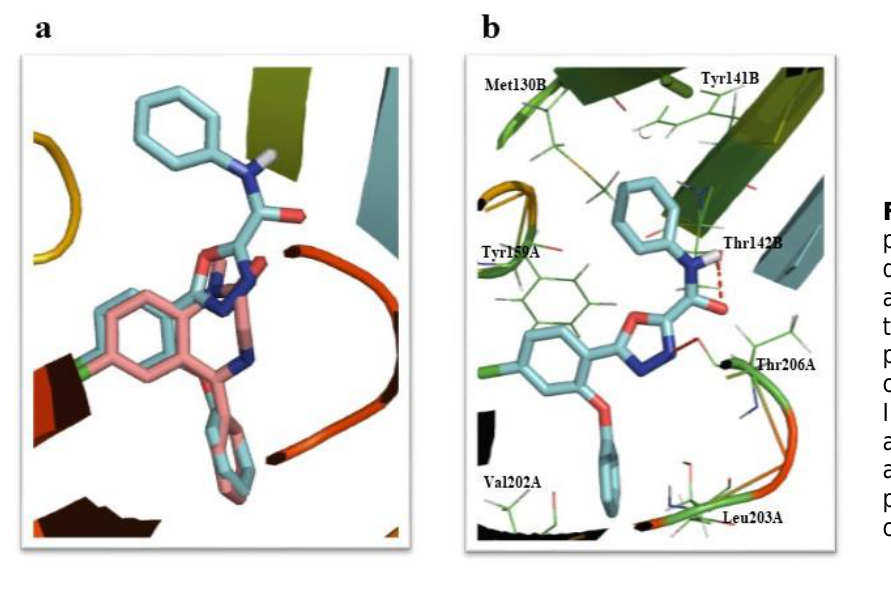
Figure 3: a : Super- posed structures